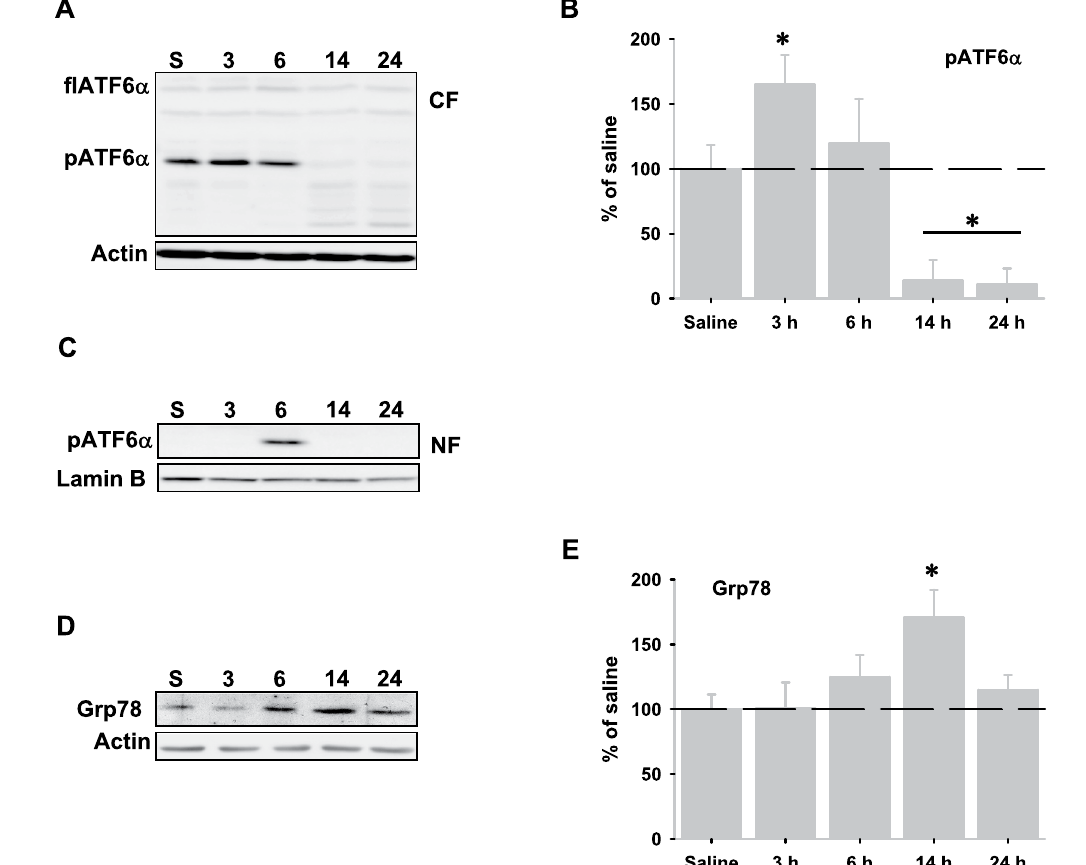
Figure 4. ATF6 α pathway is activated following LPS injection. ( A ) Representative western blot of the ATF6 α protein in the cytosolic fractions after LPS injection. Note the depletion of the processed ATF6 α (pATF6 α ) but not of the full length ATF6 α (flATF6 α ) at 14 and 24 hours. ( B ) Graphical representation of the pATF6 α expression in the cytosolic fractions determined by optical density analysis. ( C ) Representative western blot of the pATF6 α in the nuclear fractions. Note the short time expression. ( D ) Representative western blot of Grp78 protein following LPS-injection. ( E ) Graphical representation of Grp78 expression in the cytosolic fractions determined by optical density analysis. Data are presented as mean ± SD (n = 4) of percentage of variation relative to controls. * p < 0.05, significant differences compared with control (saline-injected)